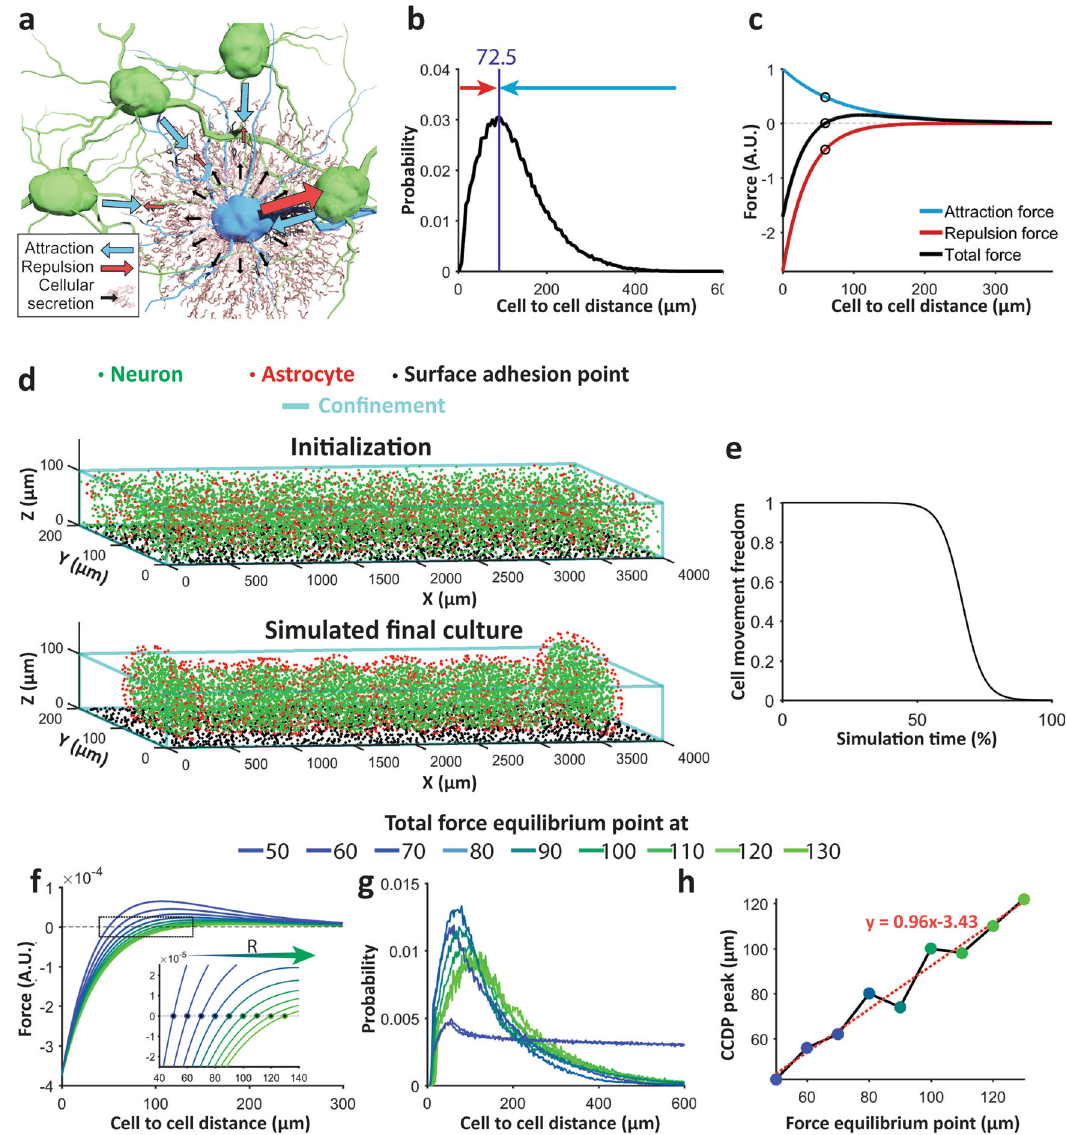
Fig. 6 In silico model. a Schematic representation of attraction (blue arrow) and repulsion (red arrow) forces exerted by blue cell on green cells. Black arrow and brown lattice show molecules (ECM, growth factors, etc.) secreted by blue cell. b Mean cell to cell distance pro fi le (CCDP) of 30 clusters from three linear 3D cultures. c Model attraction (blue) and repulsion (red) forces and their resultant total force (black). Black circles indicate force equilibrium point where attraction and repulsion forces are equal. d Random cells in con fi nement before simulation (top), simulated culture (bottom) clearly shows astrocytic super fi cial layer and clusters after reaching steady state. e Culture stiffness curve. f Total force curve with varying equilibrium point (zero- crossing) for different simulations. (Inset shows zoomed in view of the area indicated by black rectangle). g Mean CCDP of the clusters in simulated fi nal culture with different total force equilibrium points. No clusters were formed for total force equilibrium point at 50 and 60 μ m, and the cell to cell distance of entire culture was used to calculate the CCDP (traces with small peak and plateaued long tail). 8, 7, 6, 6, 6, 7, and 8 clusters were formed and CCDP of these clusters were used to calculate mean CCDP for total force equilibrium at 70, 80, 90, 100, 110, 120, and 130 μ m respectively. h Distance of total force curve equilibrium point (zero-crossing from f ) vs peak of mean CCDP (maximum point of each curve of g ) shows linear relationship. Dashed red line indicates fi tted line through the points and red text indicates fi tted line Cell movement freedom is set at 1 at the beginning, allowing free movement of the cells. After a certain period of time (after 50% of total simulation time in our simulation), this parameter drops in an inverse sigmoidal manner blocking cell movement (Fig. 6e).